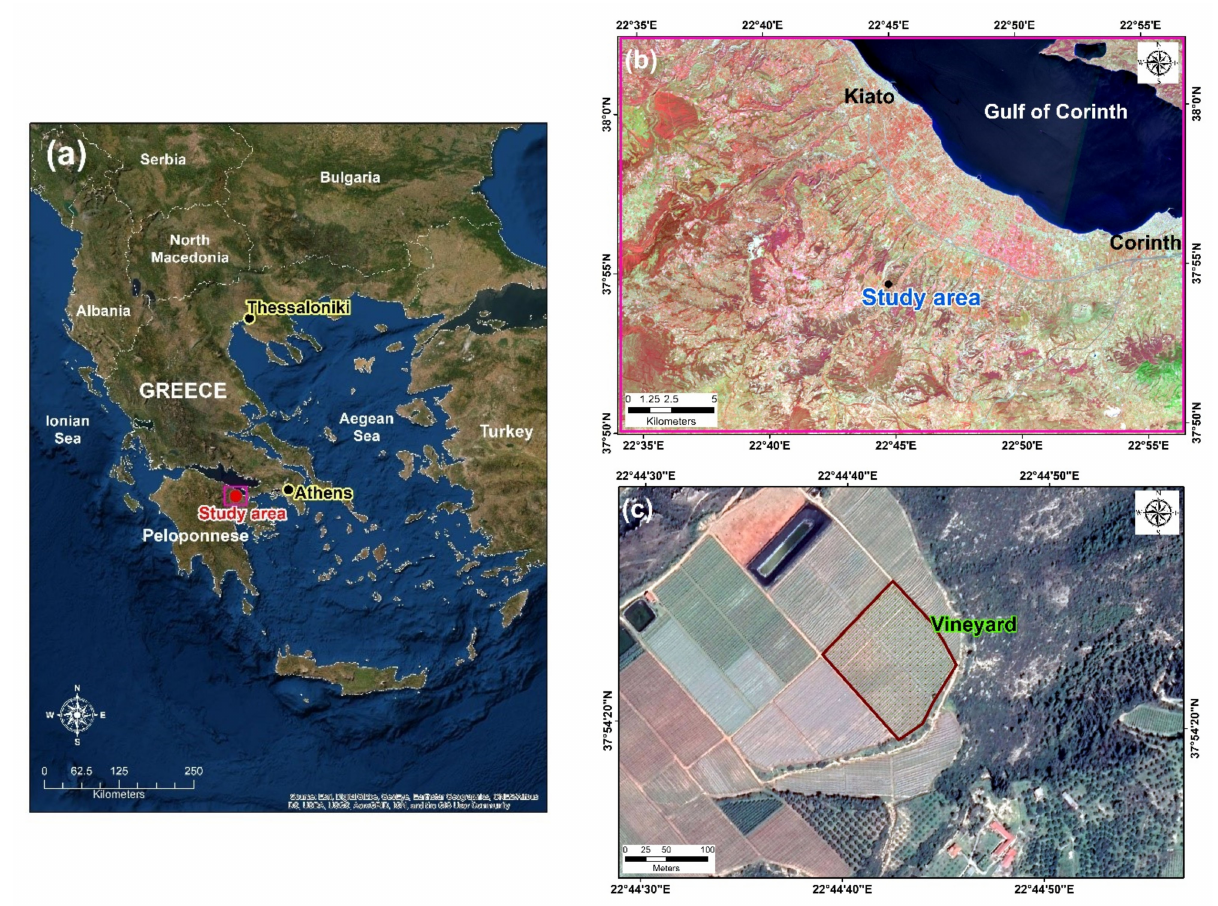
Figure 1. ( a ) The national, ( b ) regional, and ( c ) local position of the experimental vineyard